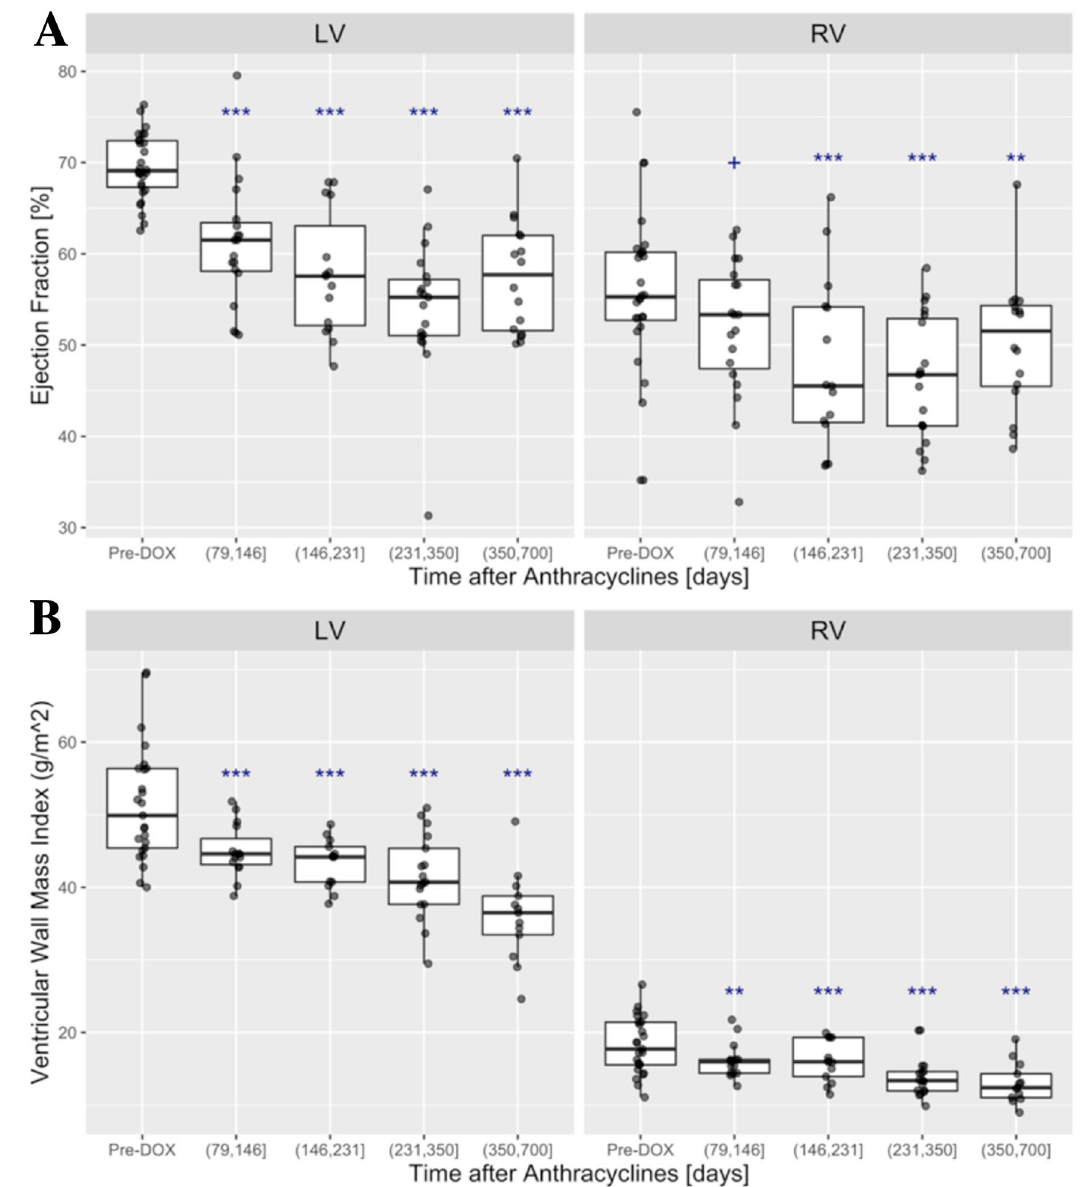
Figure 1. AB: Baseline and post-anthracycline ejection fraction (LV and RV) and ventricular mass (LV and RV). ( A ) LV EF (left) was significantly lower during all follow-up periods after anthracycline therapy ( P < 0.001); RV EF (right) reached a minimum around (146, 231] days after anthracycline initiation ( P = 0.002 vs. pre-DOX), followed by a slight recovery. ( B ) LV and RV ventricular mass index showed steady incremental decreases over the entire follow-up and in all follow-up periods both LV and RV mass index were significantly ( P < 0.001) below their baseline averages ( + P < 0.1; * P < 0.05; ** P < 0.01; *** P <